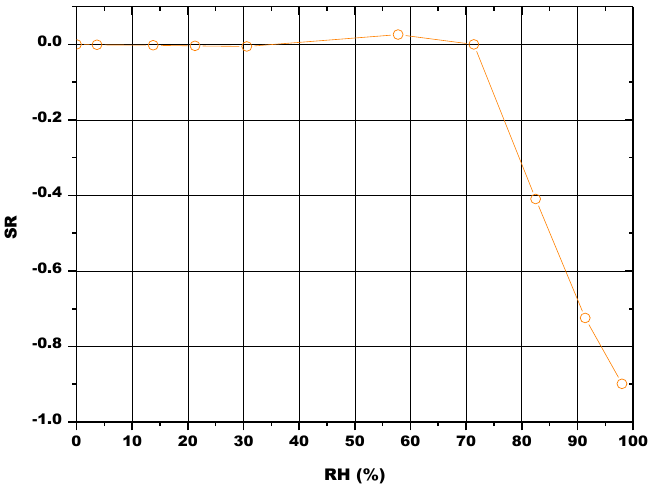
Figure 11. SR of the 5% SrO thick film sensor fired at 900 °C in function of RH at 22.3 °C ± 0.1